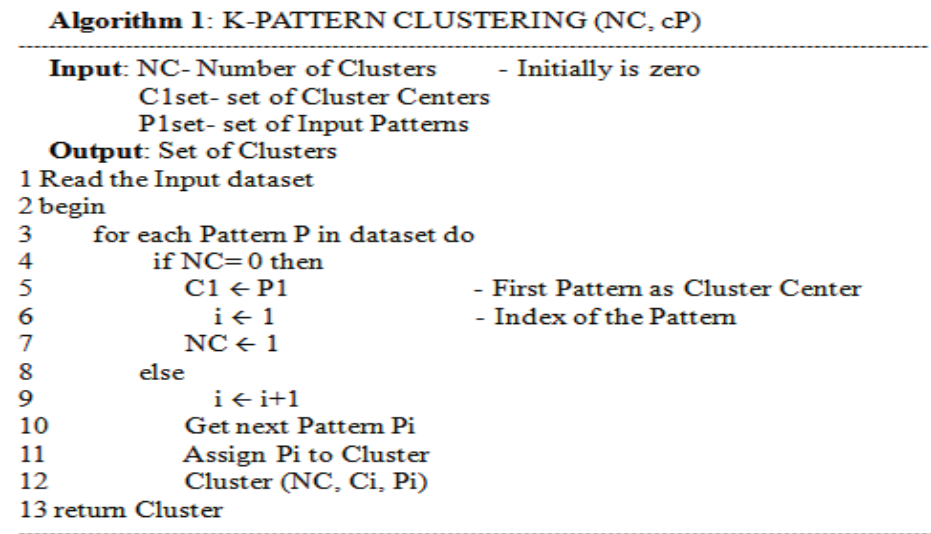
Figure 5. Process of forming frequent activity patterns [1].